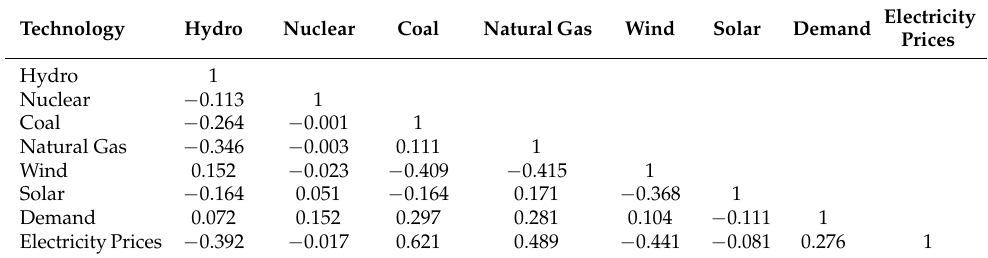
Table 5. Daily correlation between generation technologies, demand, and MIBEL prices (2015–2019)— Iberian